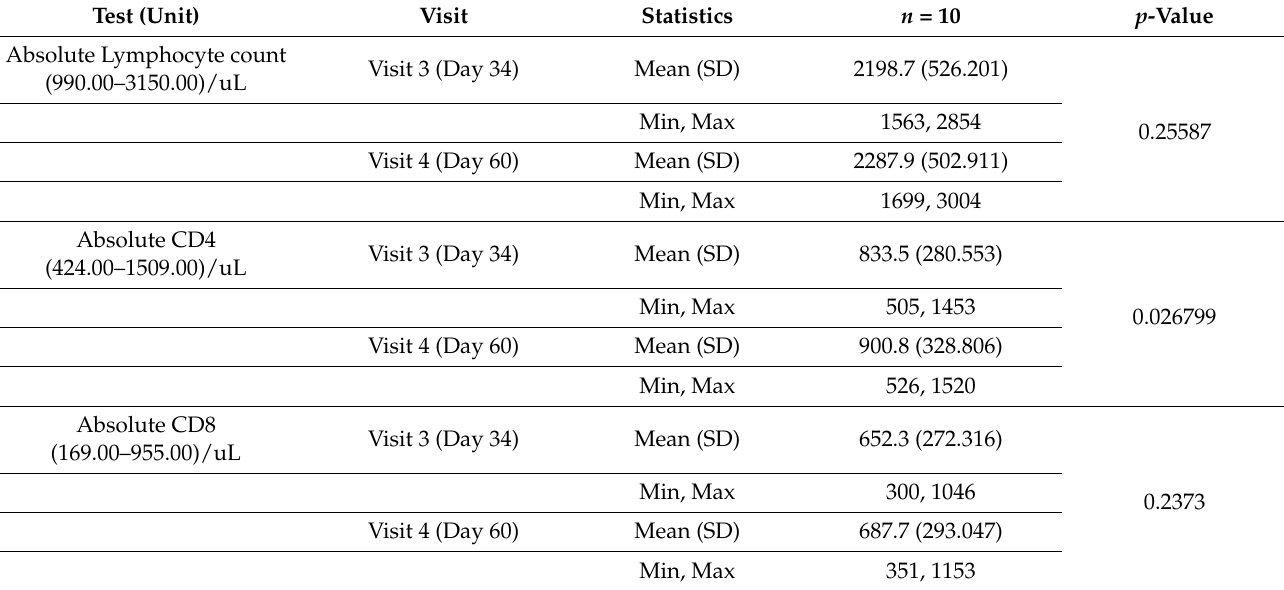
Table 4. CD panel in individuals during the study ( t -Test, Paired two samples for